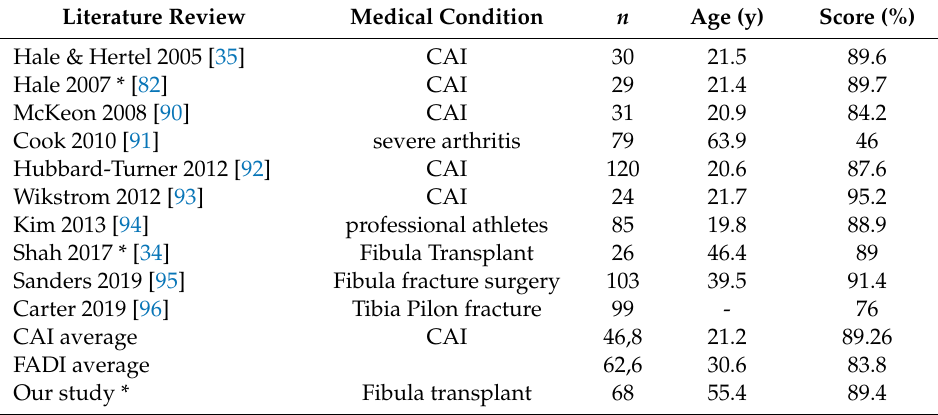
Table 4. FADI literature comparison; FADI = Foot and Ankle Disability Index; CAI = Chronic ankle instability; score shows mean value of all 26 FADI items as percentage; CAI average = mean value of all depicted studies involving subject with CAI; FADI average = overall mean value of all compared